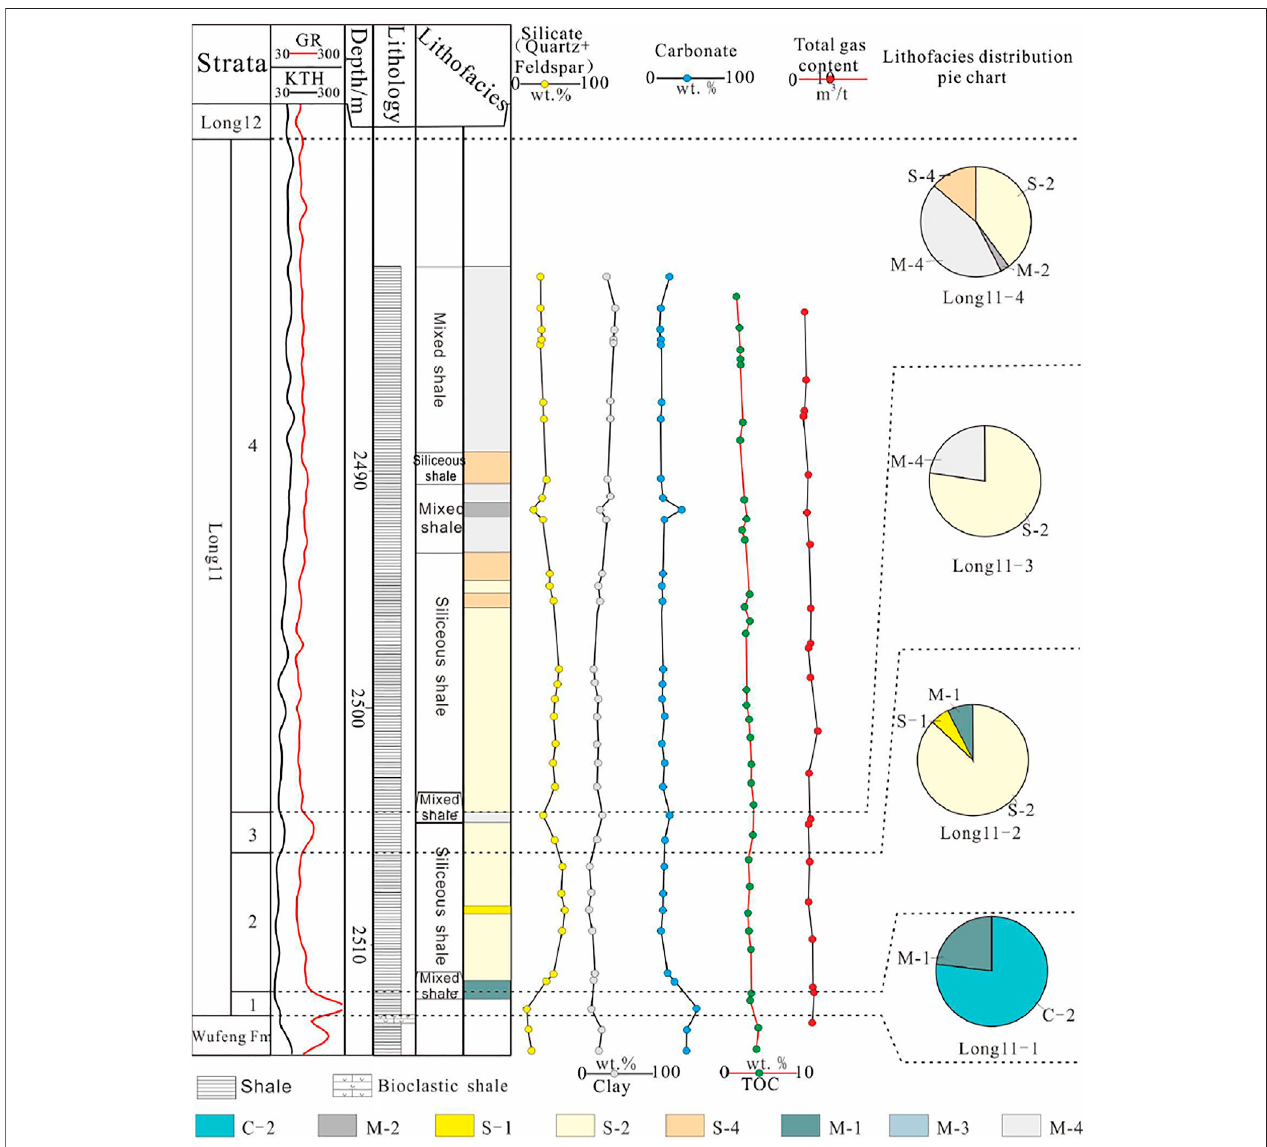
FIGURE 5 | Vertical variation sequence of the shale lithofacies of the Longmaxi Formation in Well N15 in the Changning area.